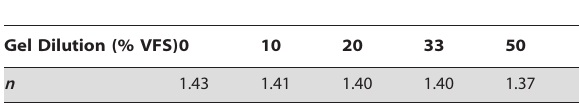
Table 1. Calculated index of refraction values ( n ) for FACTS- 001 gel diluted with vaginal fluid simulant. These values were used for accurate calibration of the mLCI